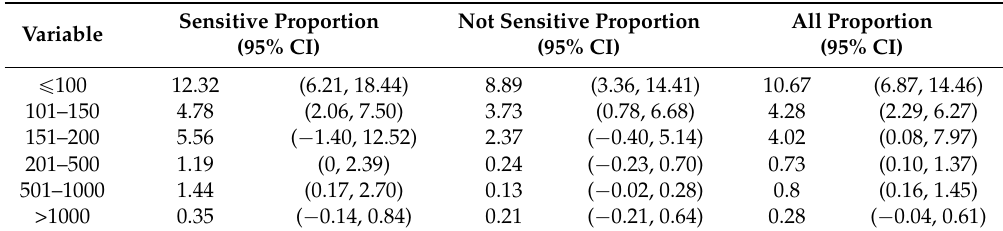
Table A5. Distance to railways and proportions of sleep disturbance due to railways in the weighted study sample, adjusted for sensitivity to noise: marginal prediction by